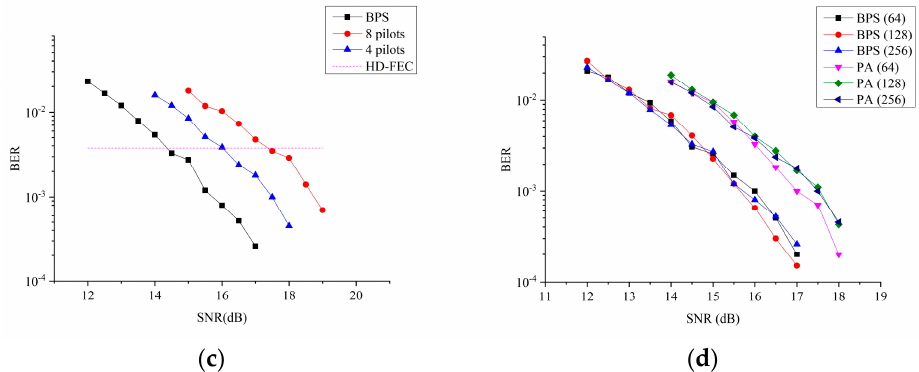
Figure 5. BER as a function of SNR for the CO-OFDM SDM transmission link under different subcarriers (( a ): 64 subcarriers, ( b ): 128 subcarriers, ( c ): 256 subcarriers, and ( d ): performance under different subcarriers). ( a ) N = 64. ( b ) N = 128. ( c ) N = 256.